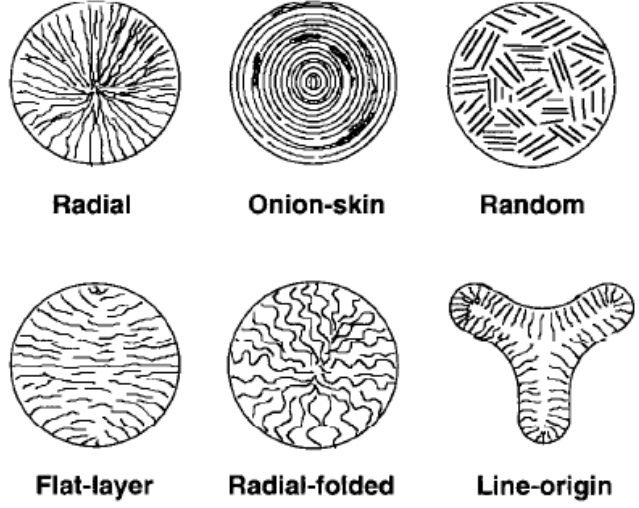
Figure 3. Microstructure of MP carbon fibers [15] (Reproduced with permission from Elsevier, ©